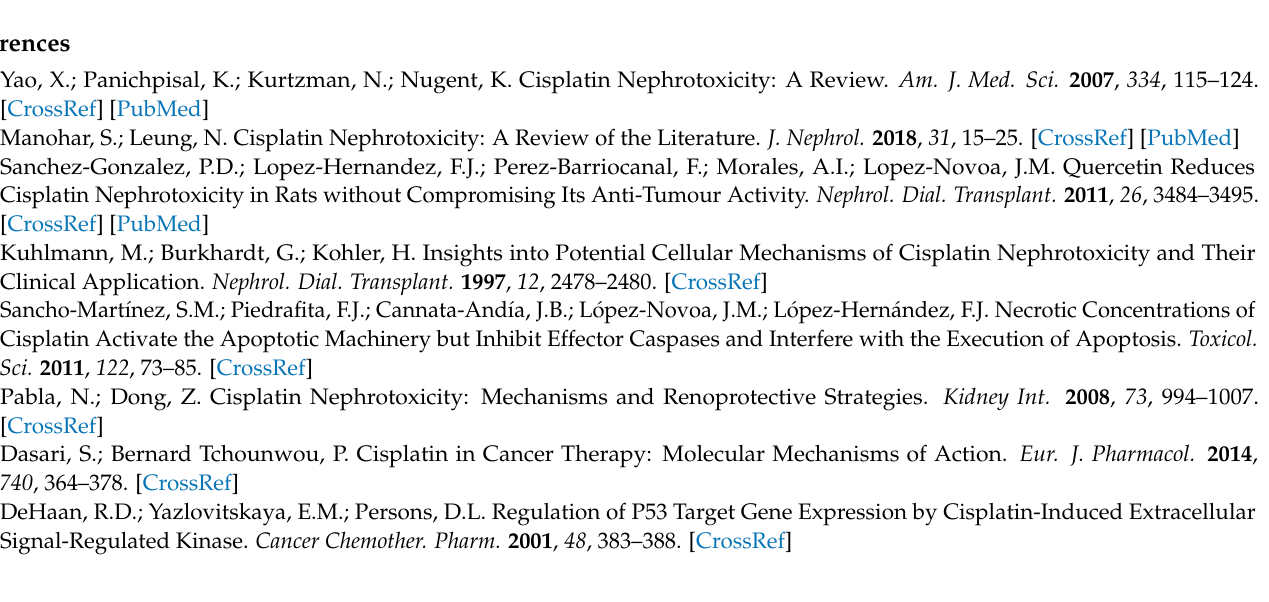
Table S1: Mass spectral data and tentative identification of the compounds detected in the analyzed urine